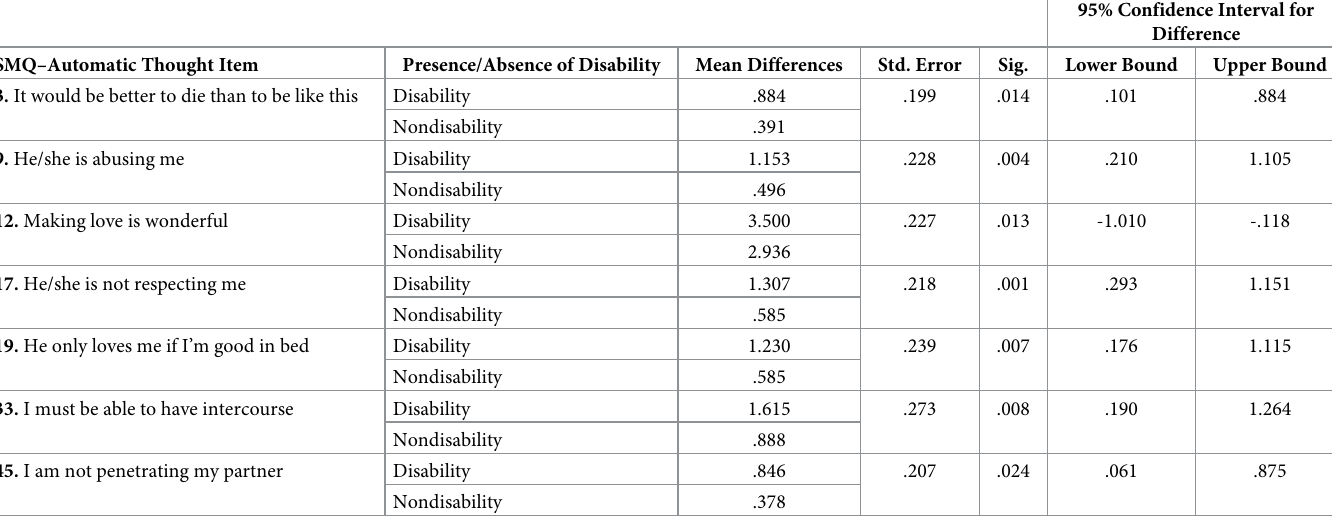
95% Confidence Interval for Difference